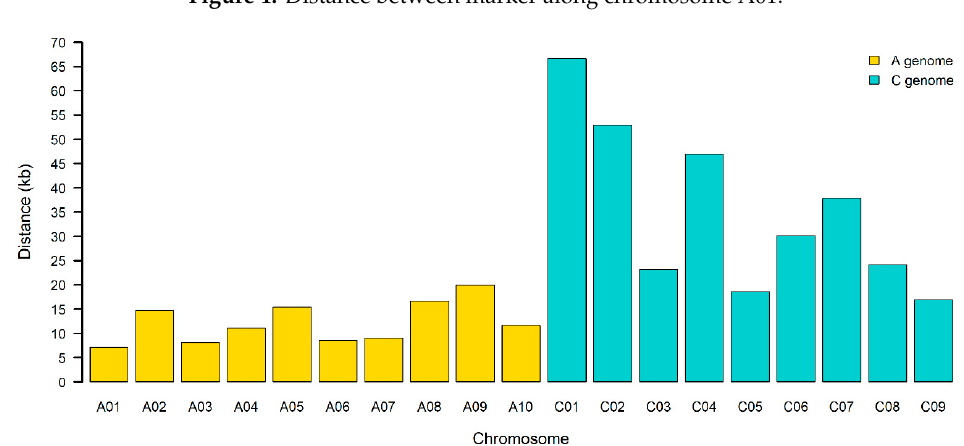
Figure 2. Linkage disequilibrium decay rate for each canola chromosome.